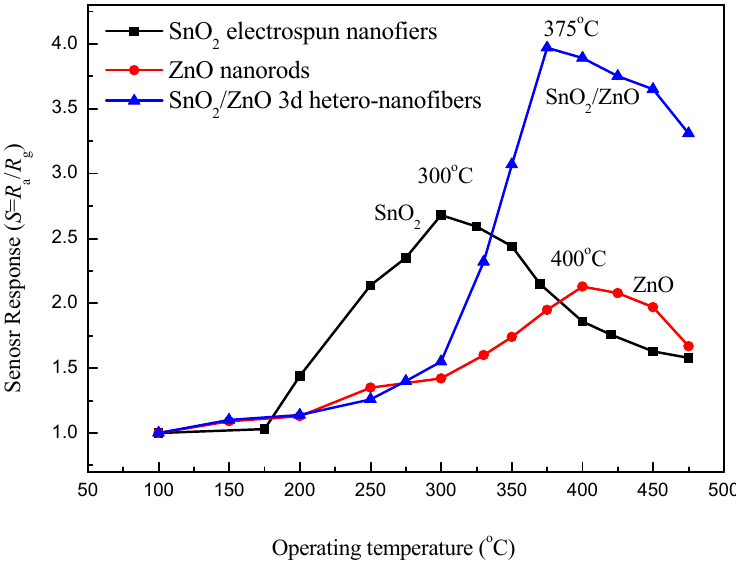
Figure 6. Responses of the SnO 2 , ZnO, and SnO 2 /ZnO sensors to 10 ppm concentration of acetone with 40% relative humidity under different operating temperatures.